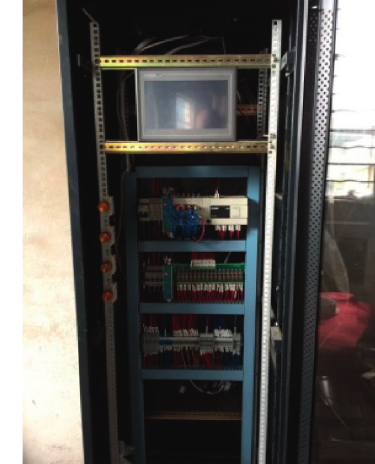
Figure 10: PLC data acquisition system.